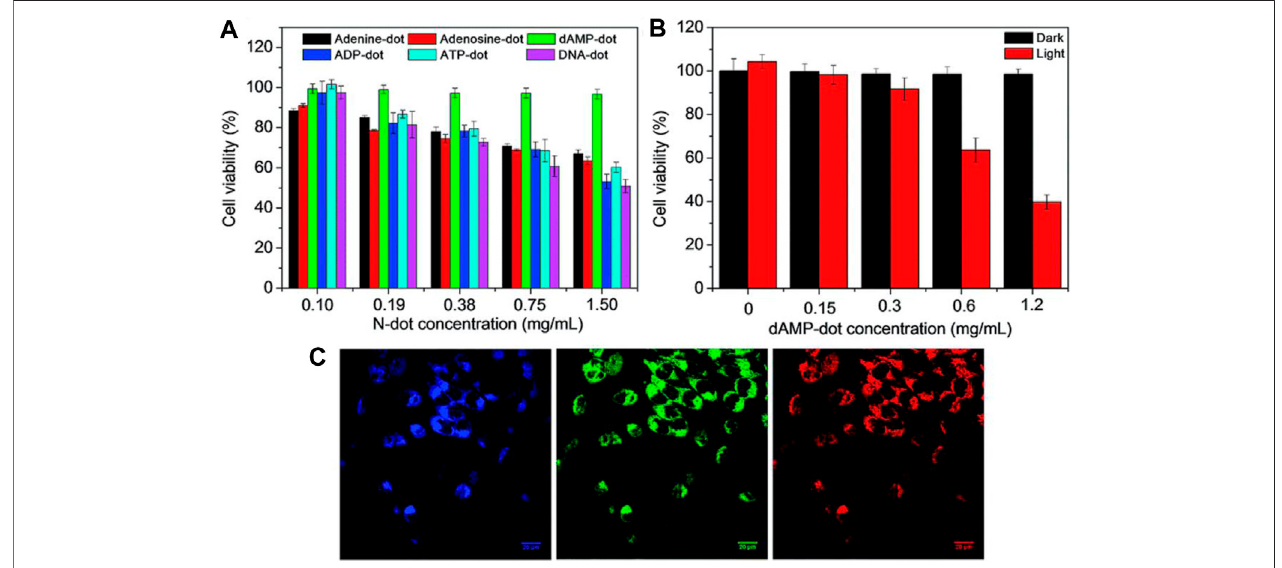
FIGURE7|(A) MTTcellproliferationassayalongwithA-dots, (B) CellulartoxicityofdAMP-CQDswhenwhitelightisirradiated atthedifferentconcentrationsfor10 min, and (C) Confocal microscope images of Hela cells with dAMP CQDs with excitation at 405, 488 and 564 nm (from left to right) resulting in different emission colors blue, red and green, respectively(Zheng et al., 2019).